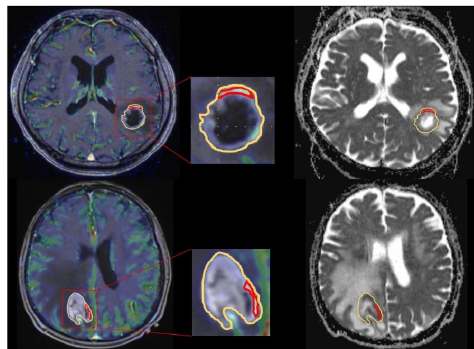
Figure 1. Exemplary apparent diffusion coefficient (ADC) and cerebral blood volume (CBV) measurement in a glioblastoma (GBM) and primary central nervous system lymphoma (PCNSL) patient. Exemplary ADC measurement of a selective region of interest (ROI)(red) in the contrast enhanced tumor area with the highest CBV and a unselective ROI (yellow) comprising the whole contrast enhancing lesion for a GBM patient (upper line) in comparison to a PCNSL patient (bottom line). After placing the ROIs carefully in the fused CBV × contrast enhanced T1 sequence map (right) ROIs are copied to the exact same position in the corresponding ADC maps